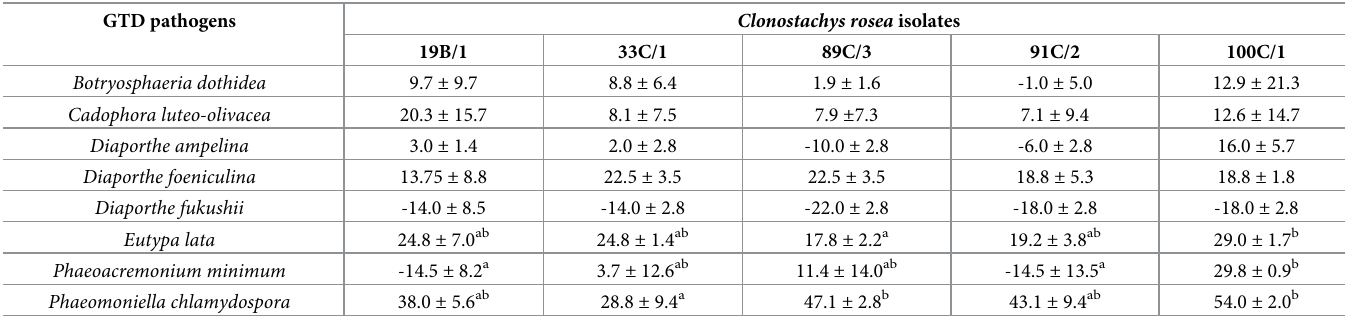
Table 2. Growth inhibition of C . rosea isolates against GTD pathogens. GTD